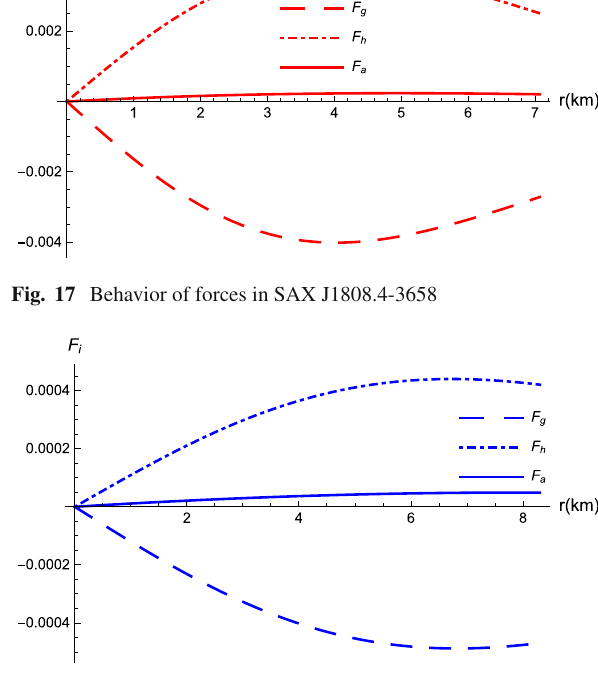
Fig. 18 Behavior of forces in SMC